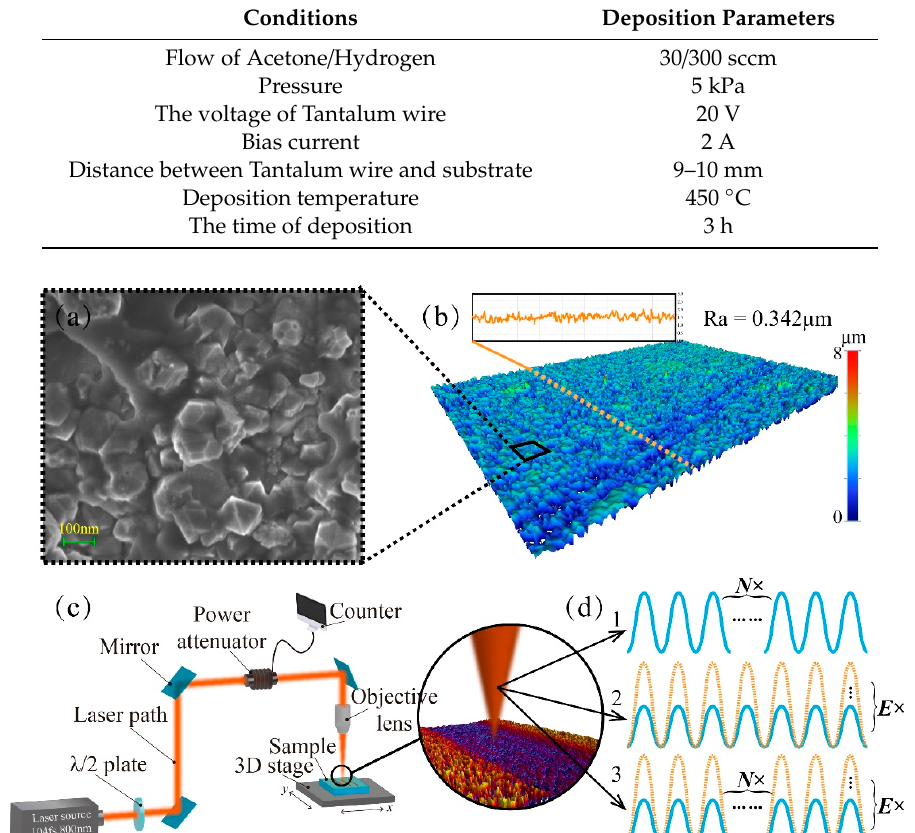
Figure 1. Experimental materials and schemes. ( a ) Surface SEM photograph of the diamond coating; ( b ) three-dimensional topography and section profile(orange curve) of the coating; ( c ) schematic of the adopted femtosecond laser processing system; and ( d ) three experimental schemes, namely, changing the number of pulses N only, changing the single pulse energy E only, and changing both N and E .